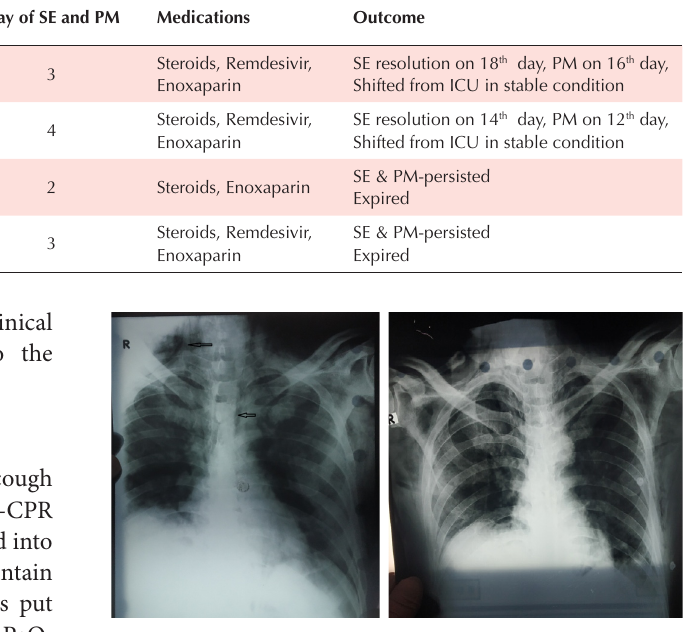
Figure 1. The presence of PM and SE on left (black arrow) and regression on